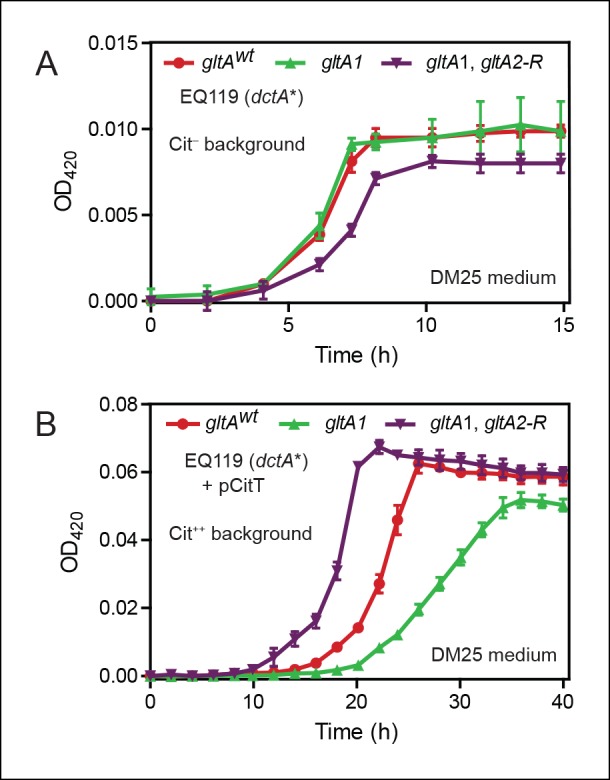
Effects of gltA alleles on growth depend on the nutrient utilization niche.(A) Growth curves of Cit– strain EQ119 containing just the evolved dctA* mutation and EQ119-derived strains reconstructed with evolved gltA alleles. Growth was measured in the DM25 medium used in the LTEE, which contains 0.0025% glucose (w/v) and 0.032% citrate (w/v). These results show that gltA1 allele has no significant effect on growth when placed into a Cit– genetic background. Further addition of the gltA2-R mutation that evolved in a Cit++ genetic background greatly inhibits growth in this genetic background that cannot utilize citrate. Error bars are the S. D. of at least three replicates. (B) Growth curves of the same EQ119-derived strains transformed with plasmid pCitT in DM25 medium. pCitT contains the activated rnk-citT promoter configuration that evolved in the LTEE; it enables strains like EQ119 with the dctA* mutation to fully utilize citrate (Cit++ phenotype) (Quandt et al., 2014). In the Cit++ genetic context, the gltA1 allele that evolved in a Cit– genetic background in the LTEE is very deleterious to growth. However, adding the gltA2 allele to this genetic background suppresses the deleterious effect of the gltA1 allele and results in further improved growth characteristics compared to the strain containing the gltAwt allele. Error bars are the S. D. of at least three replicates.